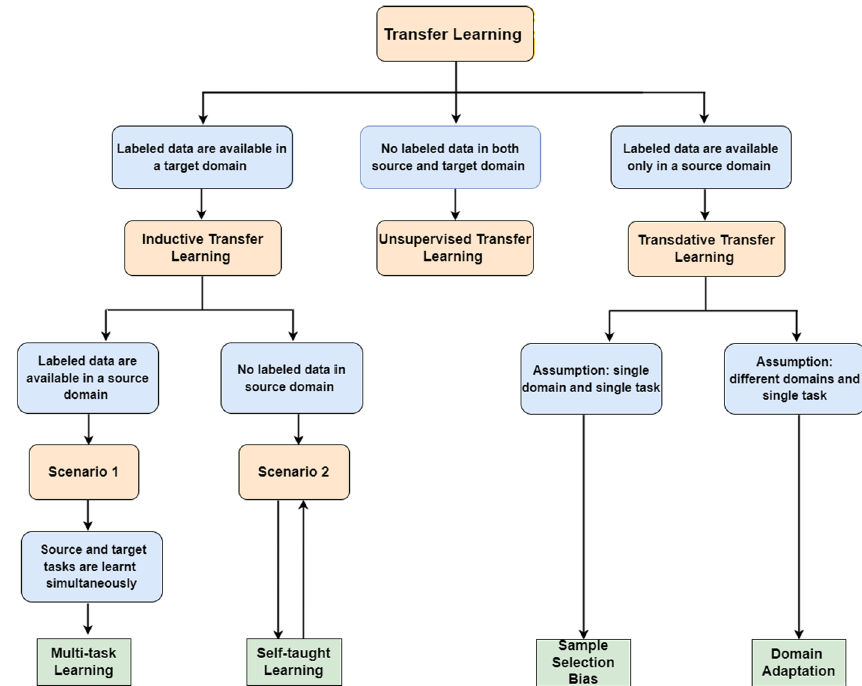
Fig. 7 Transfer learning